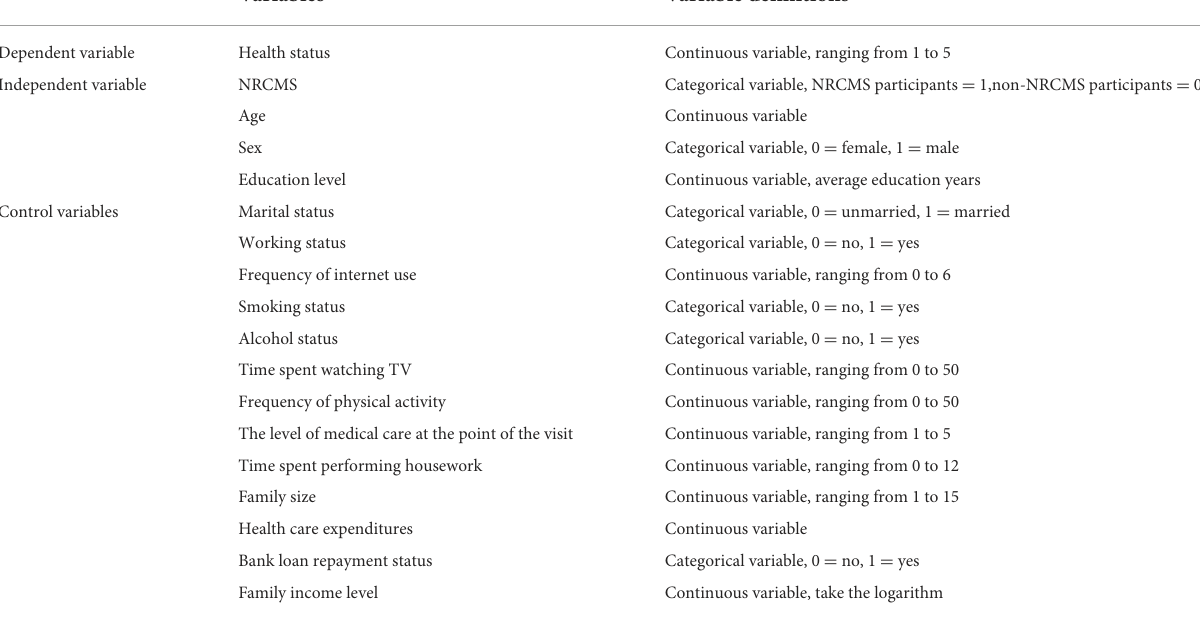
TABLE 1 Definition and descriptive statistics of various